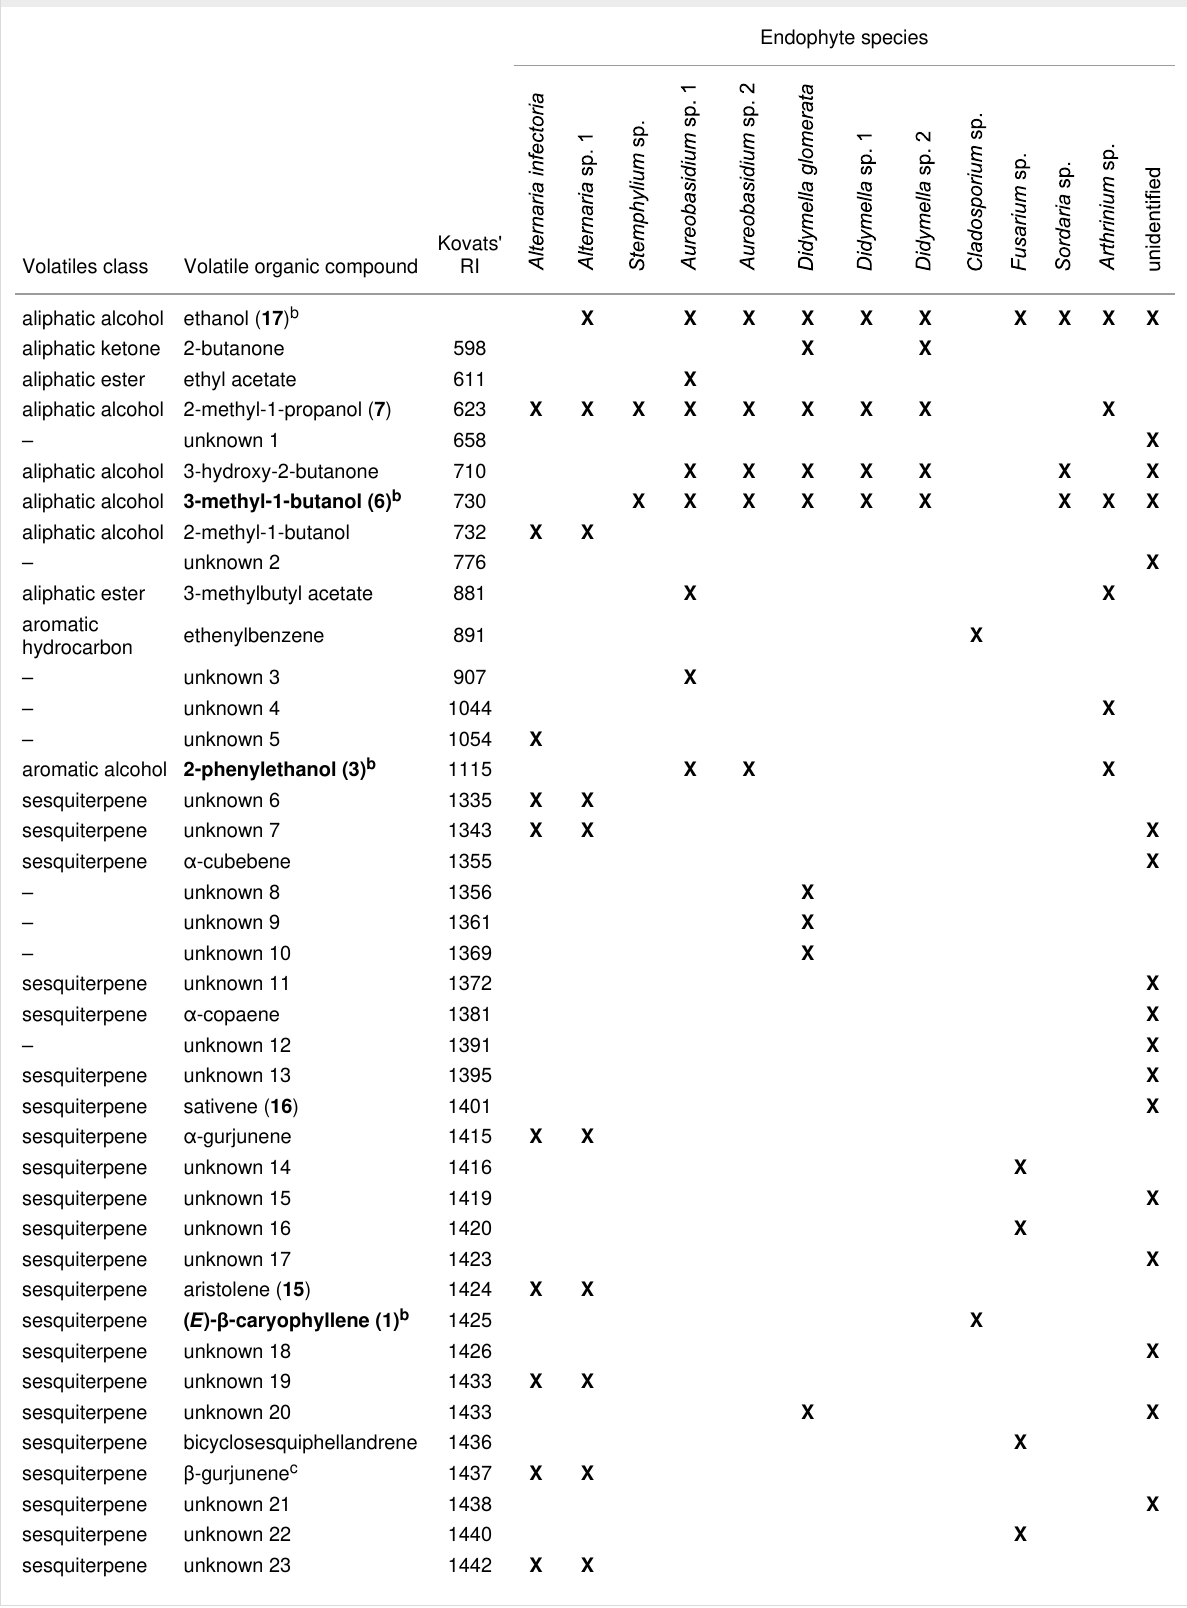
Table 2: Volatiles emitted from endophytic fungi growing in culture on potato dextrose agar (PDA). a